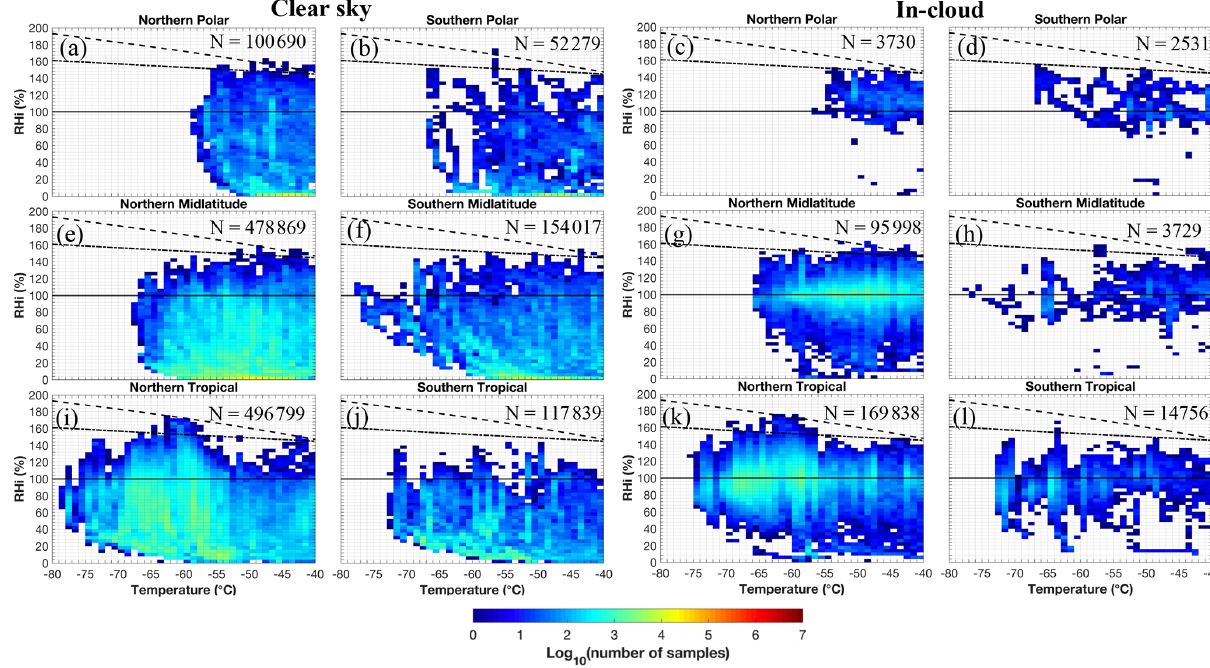
Figure 6. Distributions of RHi at various temperatures and geographical locations from in situ observations under (two left columns) clear-sky and (two right columns) in-cloud conditions. Solid and dashed black lines represent ice and liquid saturation, calculated based on saturation vapor pressure with respect to ice and liquid from Murphy and Koop (2005), respectively. Dash-dotted line denotes the homogeneous freezing threshold for 0.5µm aerosols based on Koop et al. (2000).